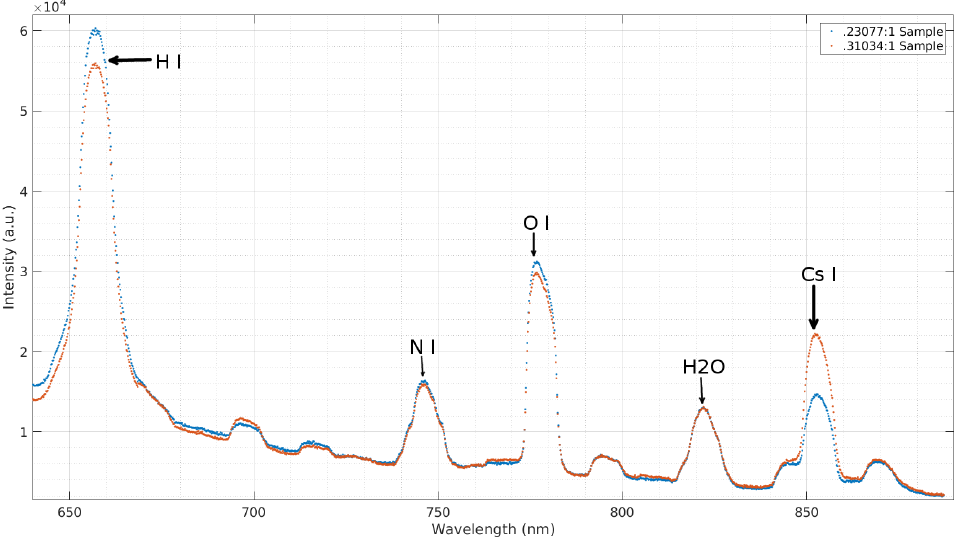
Figure 8. A comparison of two different concentrations of CsOH in deionized